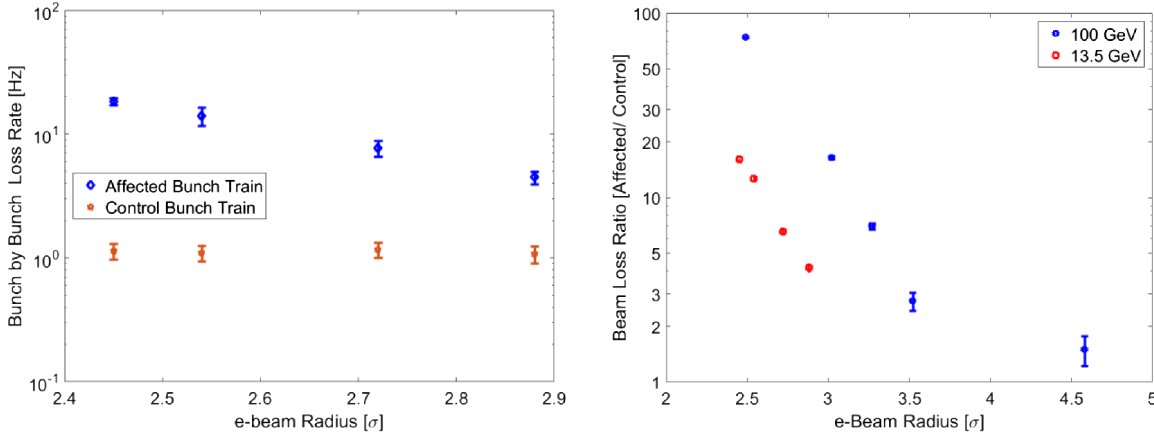
FIG. 12. Measured beam loss rate at the collimator vs beam radius. Note that the vertical scale is logarithmic for both